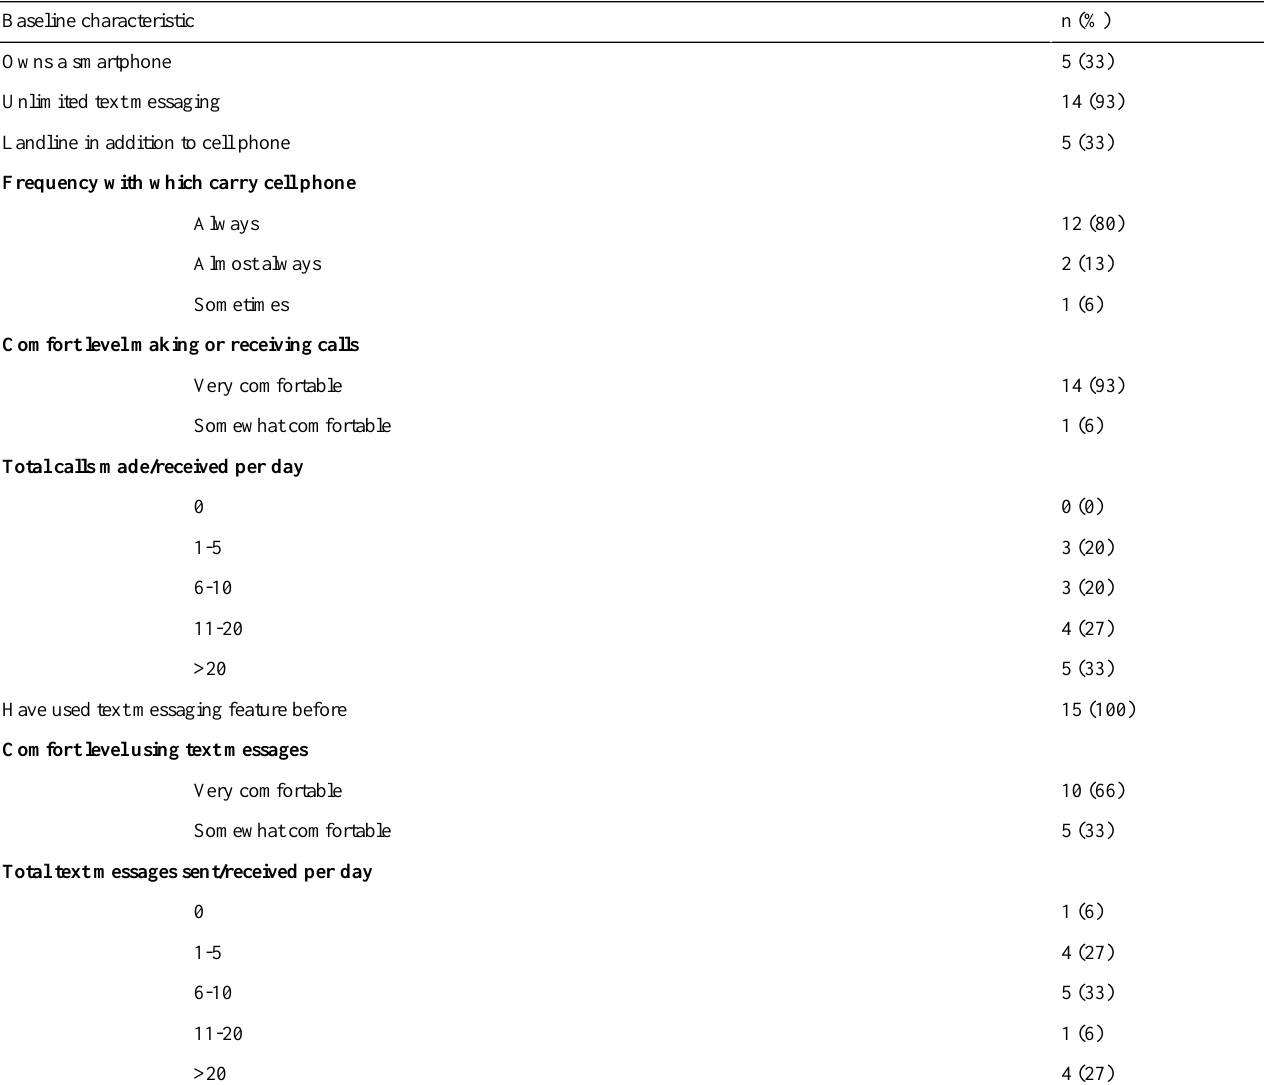
Table 2. Prior participant experience with cellular phone calling and text messaging